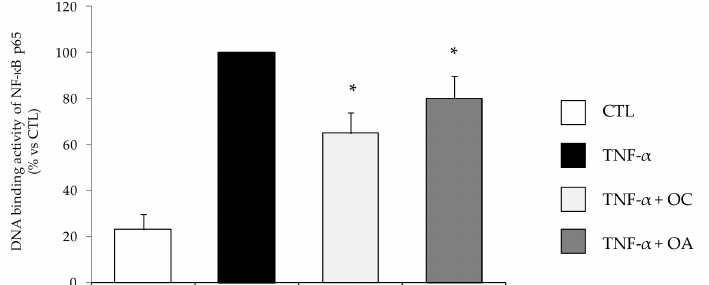
Figure 8. Modulation by OC and OA of NF- κ B activation. SGBS adipocytes were pretreated with OC or OA 25 µ mol / L (6 h) and then treated with 10 ng / mL TNF- α for 1 h. Then, nuclear proteins were extracted and assessed by ELISA to measure the DNA binding activity of the p65 NF- κ B subunit. Data (means ± SD, n = 3) are expressed as percent of TNF- α . CTL = unstimulated control. * p < 0.05 versus TNF- α